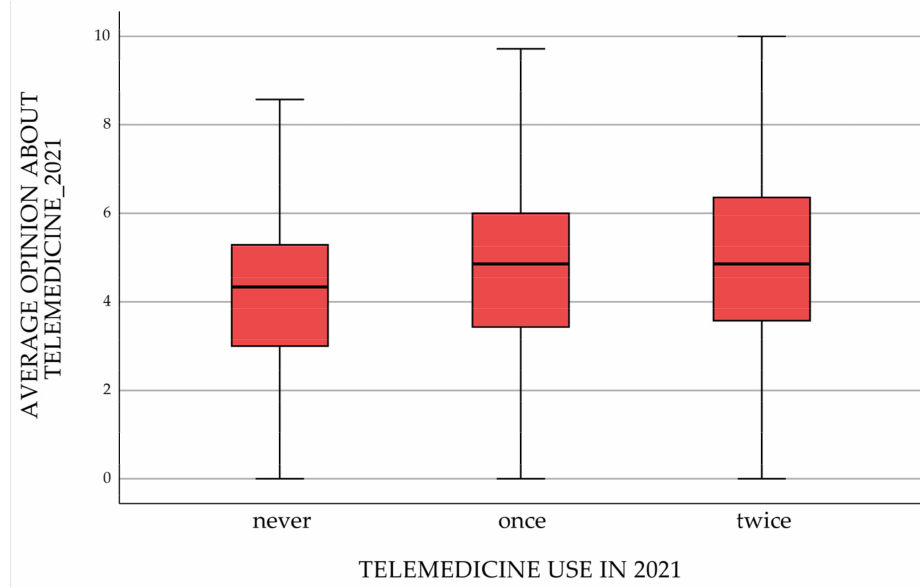
Figure 3. Average opinion on telemedicine after 1 year of the pandemic.